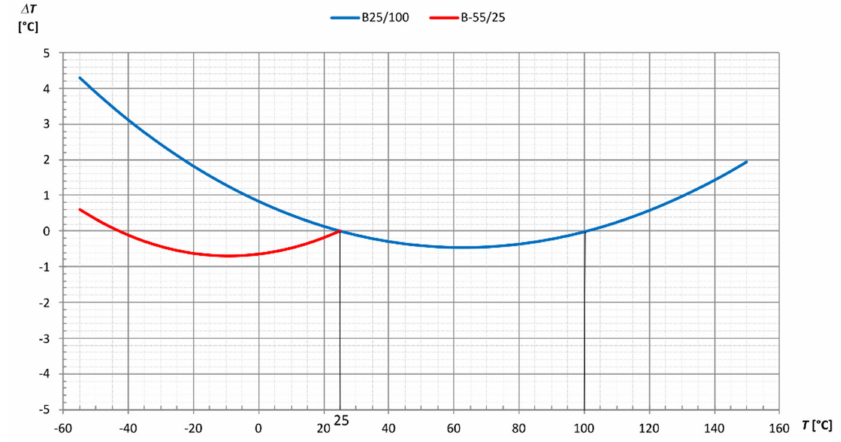
Figure 12. Temperature error for combined B equation-based